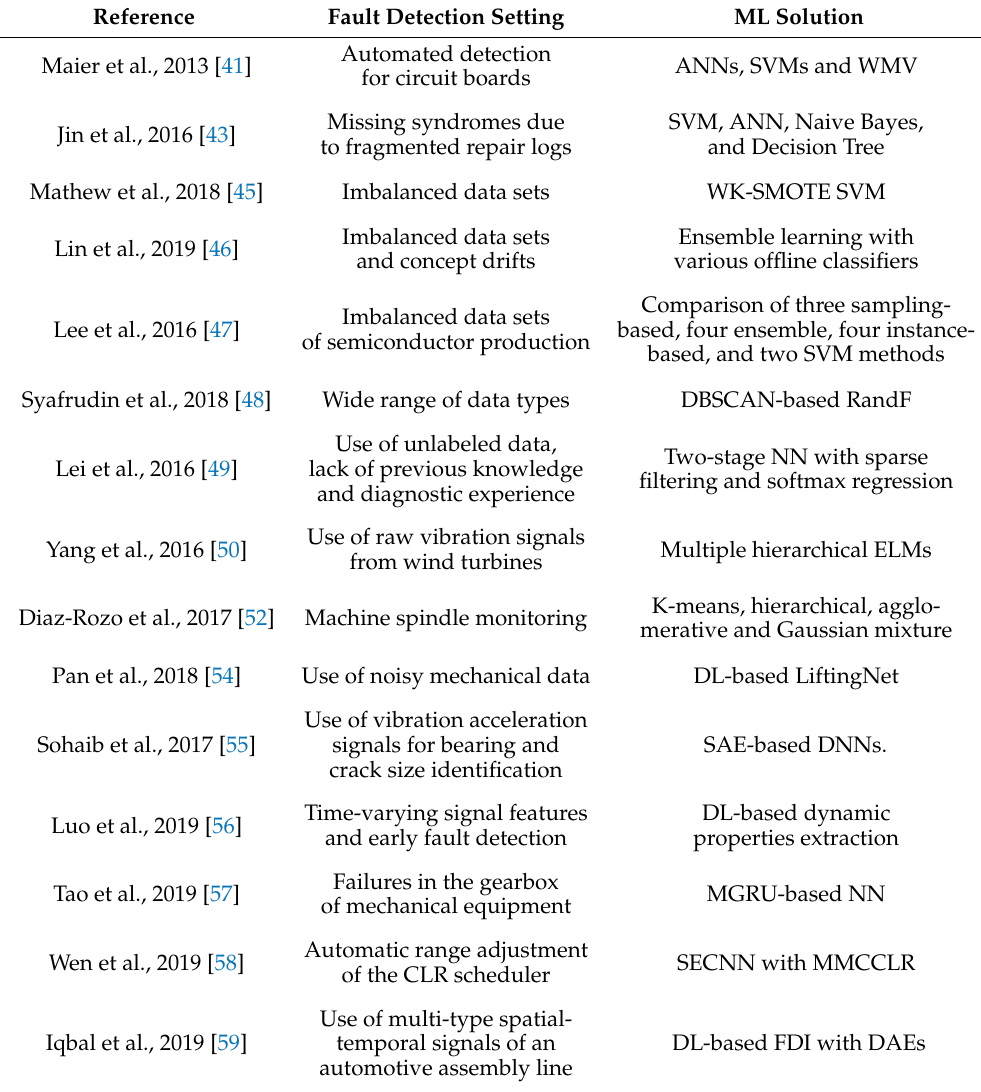
Table 3. Fault detection setting and respective ML solutions for Industry